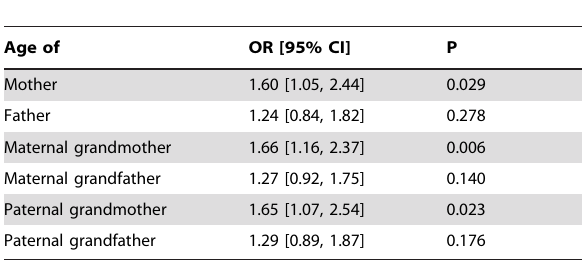
Table 2. Increase in risk [95% confidence interval] of child having ASD for each 10 year increase in age of parents and grandparents adjusted for